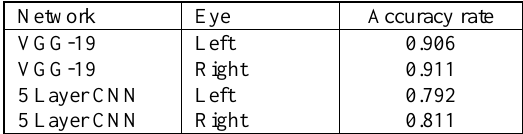
Table 1 . Percentage of correct